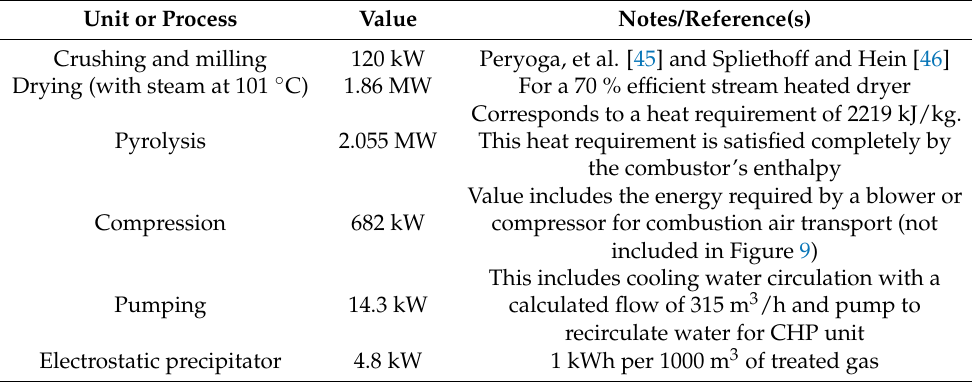
Table 6. Energy demand for different process operations determined for the base case 5000 kg/h PEFB plant. Unit or Process Value Notes/Reference(s) Crushing and milling 120 kW Peryoga, et al. [45] and Spliethoff and Hein [46] Drying (with steam at 101 ◦ C) 1.86 MW For a 70 % efficient stream heated dryer Corresponds to a heat requirement of 2219 kJ/kg. Pyrolysis 2.055 MW This heat requirement is satisfied completely by the combustor’s enthalpy Compression 682 kW compressor for combustion air transport (not included in Figure 9) Pumping 14.3 kW recirculate water for CHP